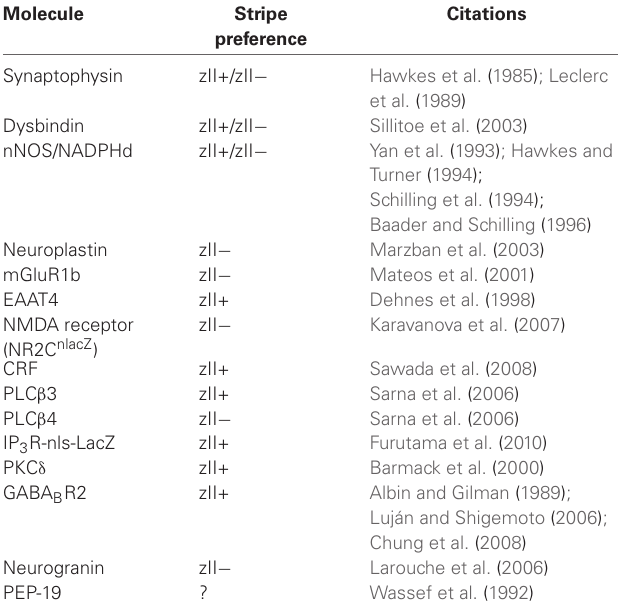
Table 1 | A list of the synaptic molecules with striped expression patterns referred to in the text; whether they are preferentially expressed in zebrin II+ (zII+) or zebrin II − (zII − ) stripes (or a mixture of both); and pertinent citations